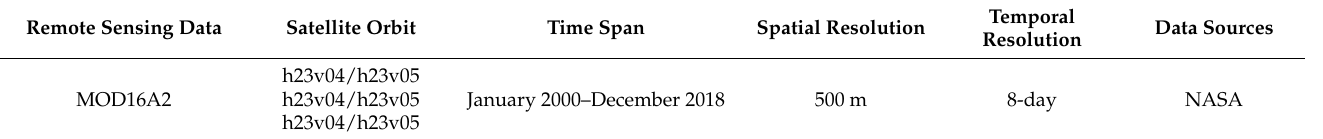
Table 1. Attribution of MOD16A2 remote sensing